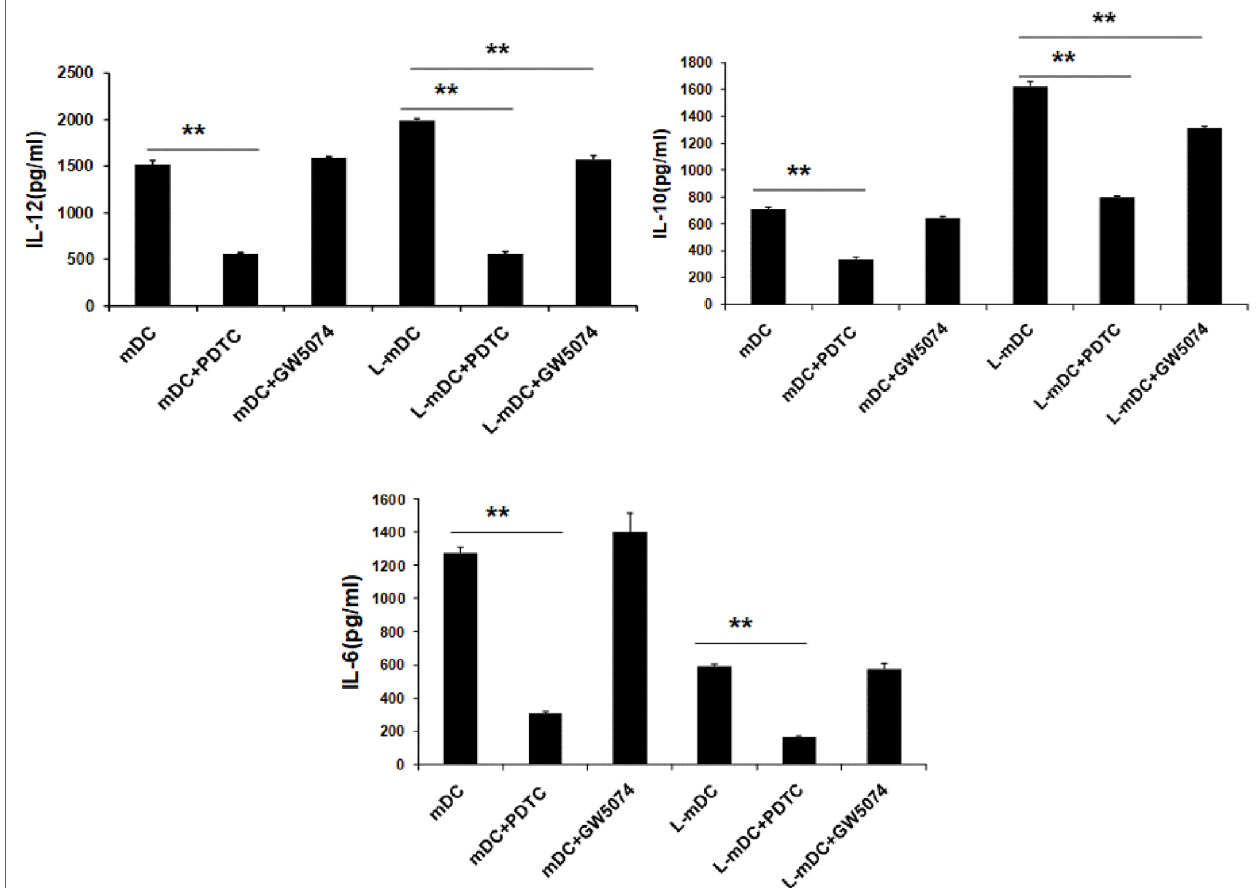
FigUre 6 | Upregulation of IL-10 and IL-12 in L-mDCs is dependent on Raf-1 activity. DCs were stimulated with LPS and secretion of cytokines was measured by enzyme-linked immunosorbent assay. DCs were treated with GW5074, a Raf-1 inhibitor, or PDTC, an NF- κ B inhibitor, as a control. Average cytokine measure of three independent experiments ± SD is shown (** p <